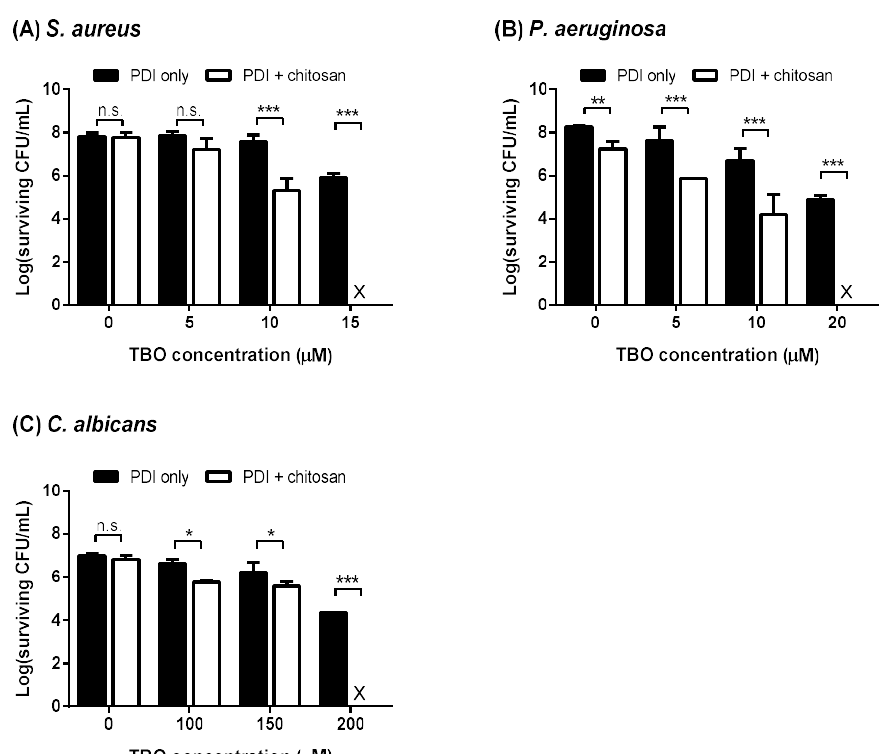
Figure 1. Chitosan augments the killing efficacy of photodynamic inactivation (PDI). Planktonic cells of ( A ) Staphylococcus aureus , ( B ) Pseudomonas aeruginosa , and ( C ) Candida albicans subjected to toluidine blue O (TBO)-mediated PDI under the light dose of 50 J cm −2 . Following PDI, microbial cells were further treated with chitosan for 30 min. The concentrations of chitosan used for S. aureus and P. aeruginosa were 0.025% and 0.25%, respectively. For C. albicans , 0.25% chitosan was used post-incubation with PDI. The survival rate of each sample was then measured by plate count. At least three repeated experiments were performed to determine the surviving cells, expressed in log colony forming units (CFUs) mL −1 . Each value is the mean from three independent experiments ± standard deviation (SD), X indicates the complete killing of cells, n.s. denotes no significance, * p < 0.05, ** p < 0.01, and *** p < 0.001.